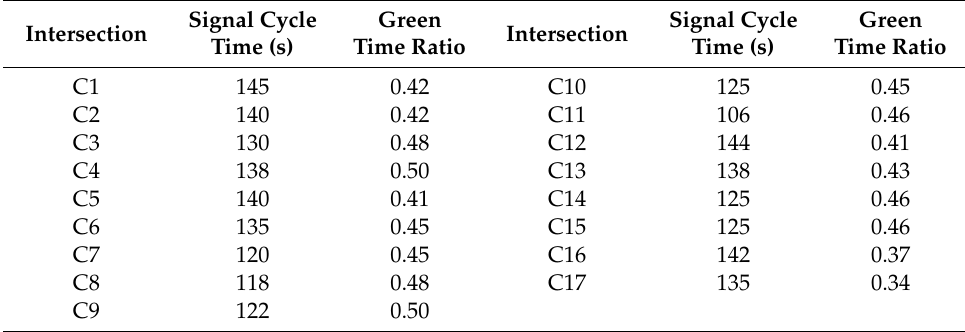
Table 1. Parameters of each tra ffi c signal systems at the